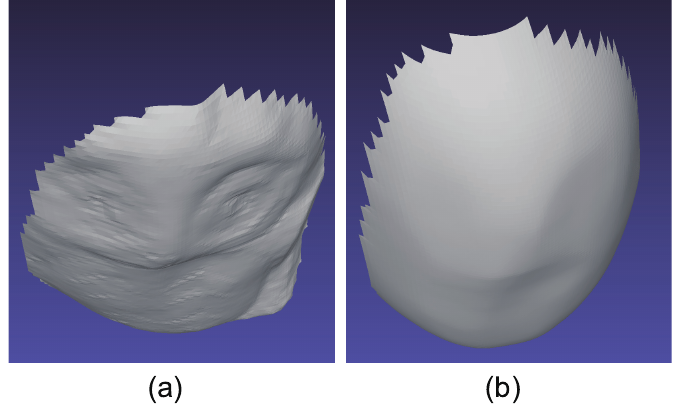
Figure 18. The results for owl object, which only causes diffuse reflection. Estimated geometry [owl]: ( a ) Naive color photometric stereo and ( b ) our method. The proposed method is not affected by the albedo difference.